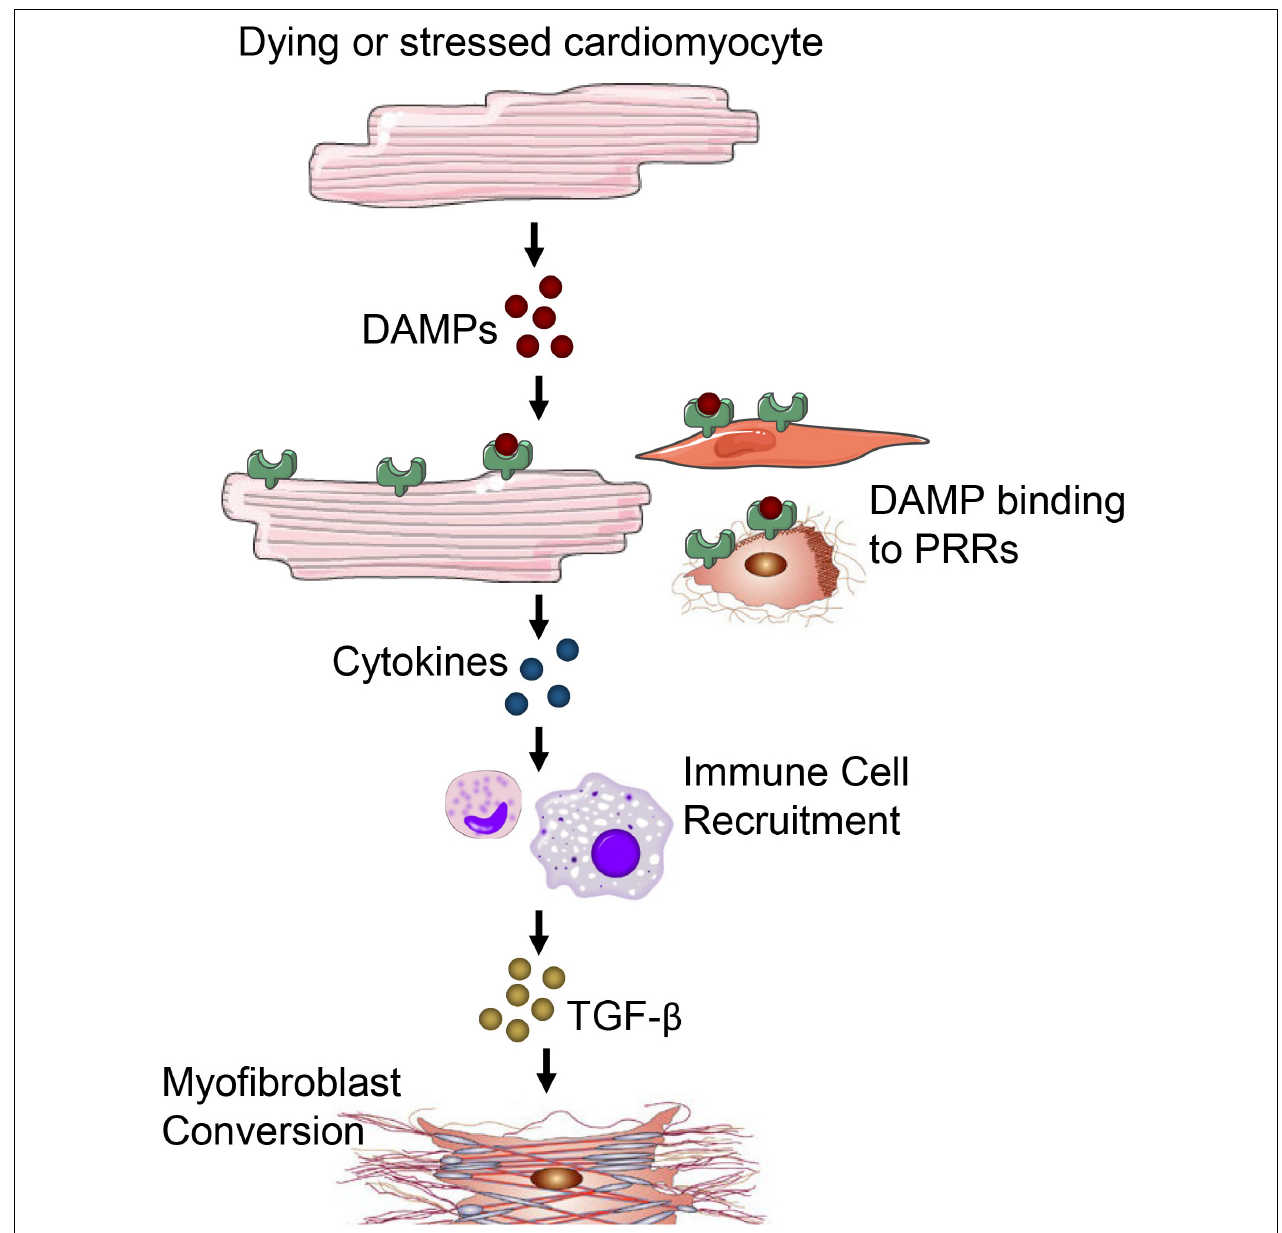
FIGURE 3 | Damage or death of cardiomyocytes leads to the release of DAMPs. DAMPs acting through PRRs on neighboring cardiomyocytes, fibroblasts, resident immune cells, endothelial cells and other parenchymal cells of the heart promote cytokine and chemokine release. Immune cells migrate in response to cytokine/chemokines in the heart and secrete TGF- β and other pro-fibrotic factors to promote fibrosis and myofibroblast